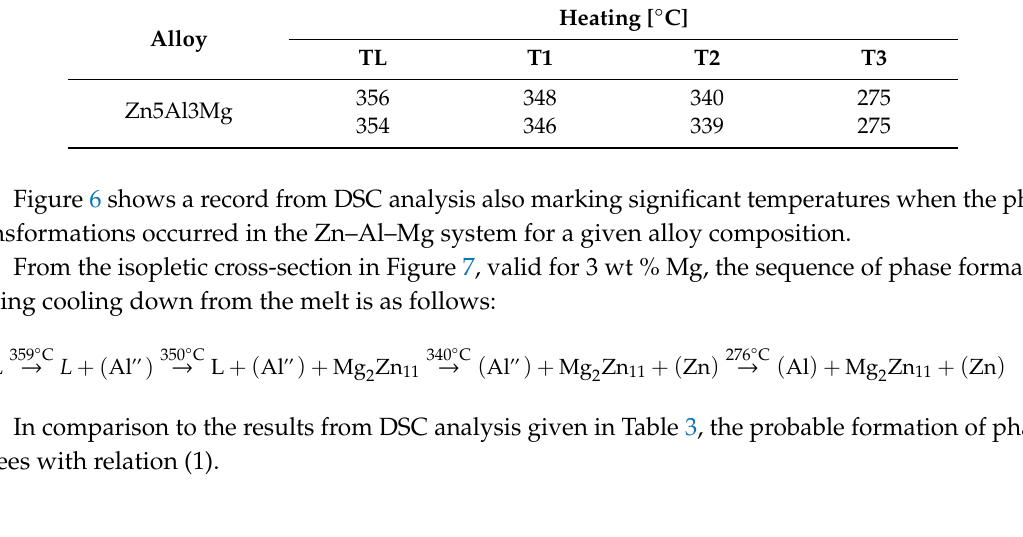
Table 3. Temperatures of phase transformations by DSC